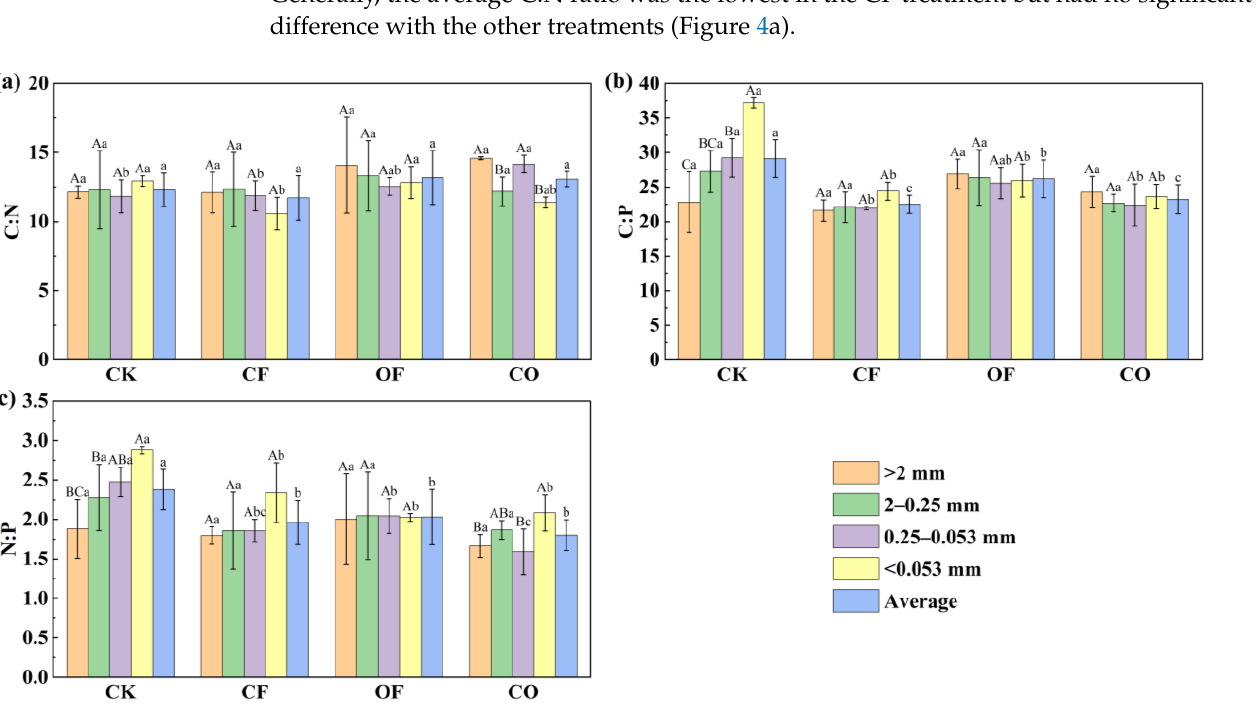
Figure 4. Ecological stoichiometric characteristics of soil aggregate under different fertilization treatments. ( a ) C:N (SOC/TN); ( b ) C:P (SOC/TP); ( c ) N:P (TN/TP). Different uppercase letters indicate significant differences in aggregate fraction within the same treatment ( p < 0.05), and different lowercase letters indicate significant differences between different treatments within the same aggregate fraction ( p < 0.05). CK, no fertilizer; CF, chemical fertilizer; OF, organic fertilizer; CO, chemical fertilizer (50% N) plus organic fertilizer (50% N).